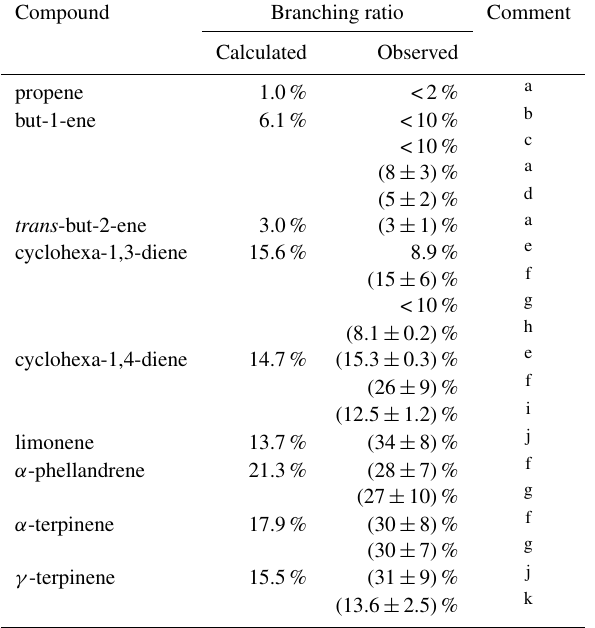
Table 13. Comparison of estimated and observed total branching ra- tios for H-atom abstraction, k abs /(k abs + k add ). The estimated values correspond to 298K, and the observed values are for temperatures at or near